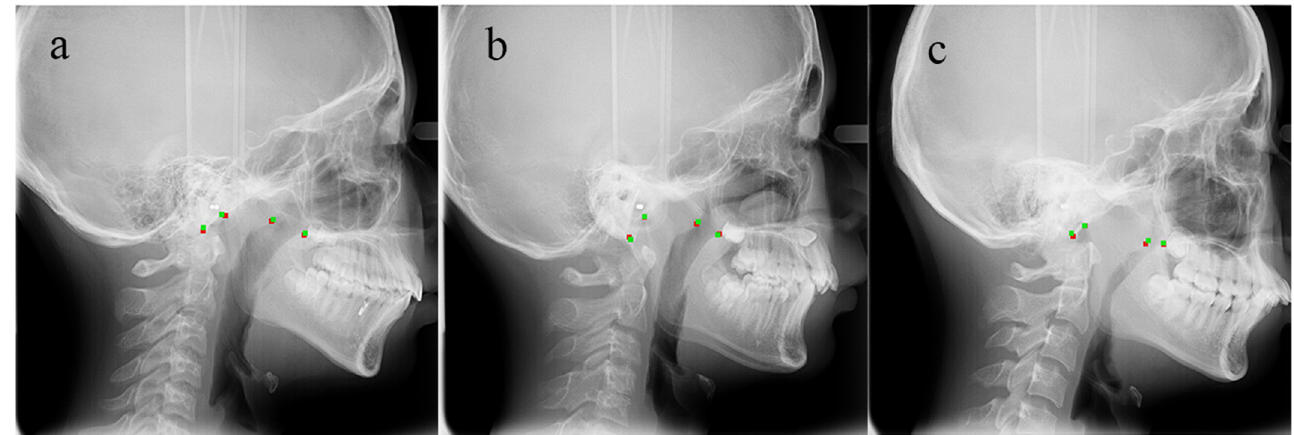
Figure 8. Validation dataset image comparison (green points represent ground truth; red points represent detection). The normal case ( a ); moderate hypertrophic case ( b ); severe hypertrophic case ( c ).